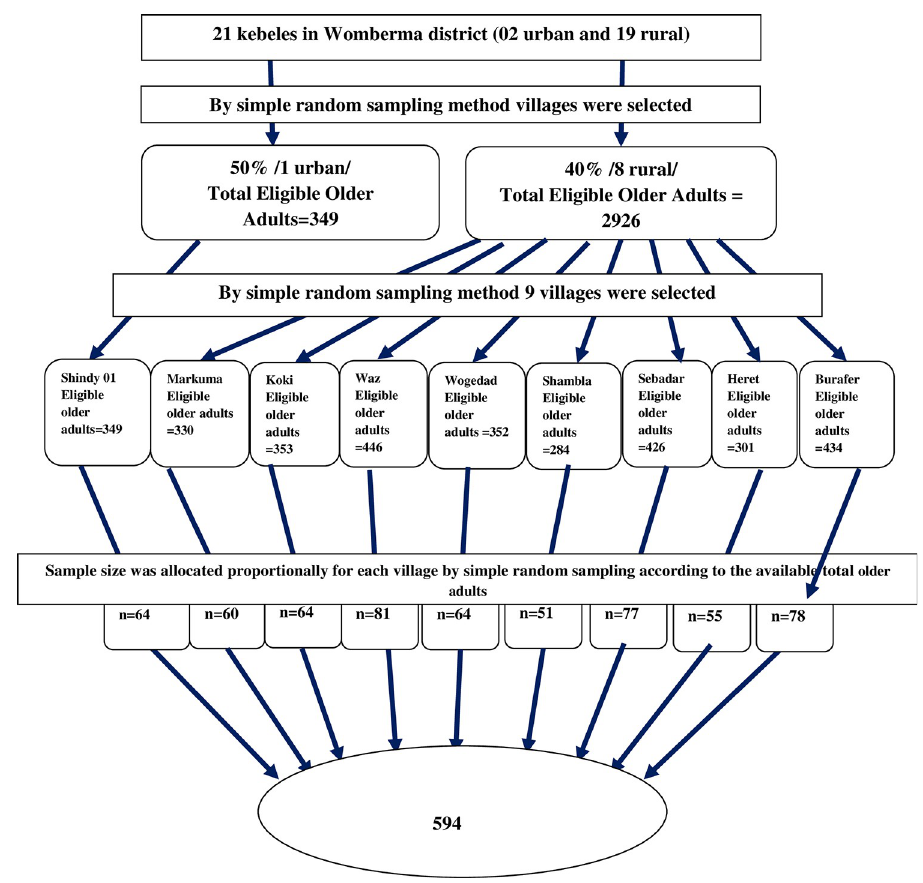
Fig 1. Schematic representation of the sampling procedure, the prevalence of undernutrition and associated factors among older adults in Womberma district, West Gojjam, North West Ethiopia, 2020, (n = 594).